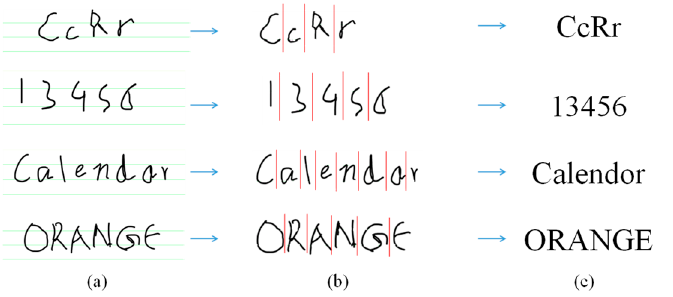
Figure 19. Recognition results for some messy images: ( a ) Images input into the system, ( b ) images with segmentation lines, and ( c ) recognition results.